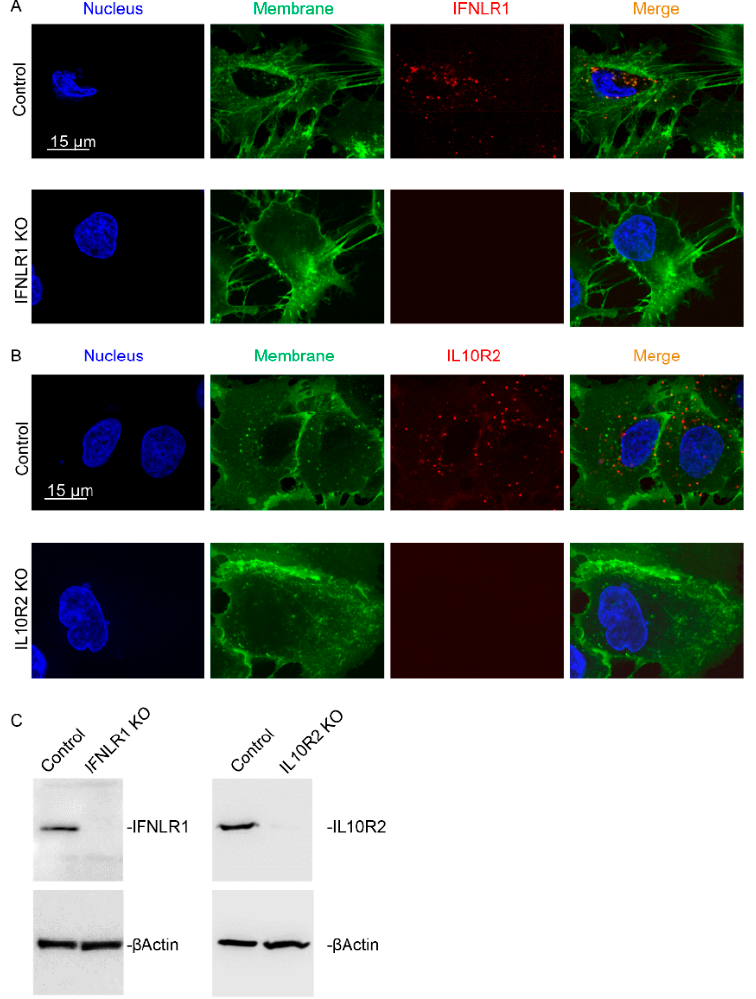
Figure 5. Characterization of IFNLR1 and IL10R2 knockout cell clones. High resolution confocal immunofluorescence images ( A , B ) and immunoblot analysis ( C ) of IFNLR1 and IL10R2 were per- formed in control and CRISPR/Cas9 edited HuH7 cells. Nuclei are shown in blue, membrane in green, IFNLR1 and IL10R2 are presented in red. Scale bar 15 µm. Representative pictures from several knockout clones are shown ( A , B ). An equal amount of several knockout clones was loaded per lane for Western blot analysis of IFNLR1 ( n = 5) and IL10R2 ( n = 2) ( C ).